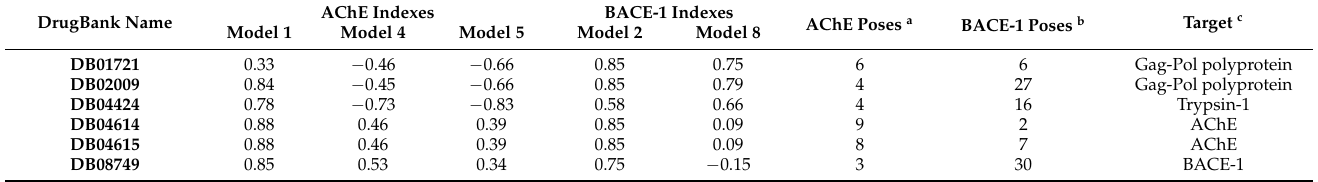
Table 4. Six experimental drugs with high models’ indexes and docking